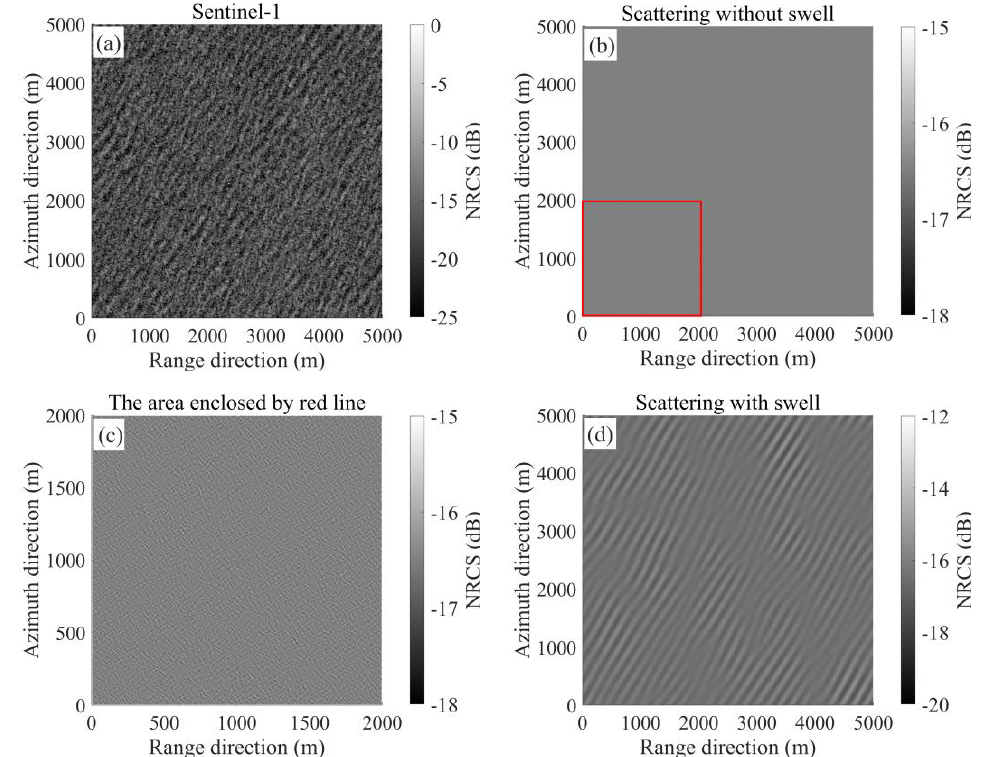
Figure 17. The scattering images corresponding to ID 1 of ( a ) the Sentinel-1 data, ( b ) simulation based on modified TSM + Tayfun sea surface without swell, ( c ) the area enclosed by red solid line in ( b ), and ( d ) simulation based on modified TSM + Tayfun sea surface with swell.